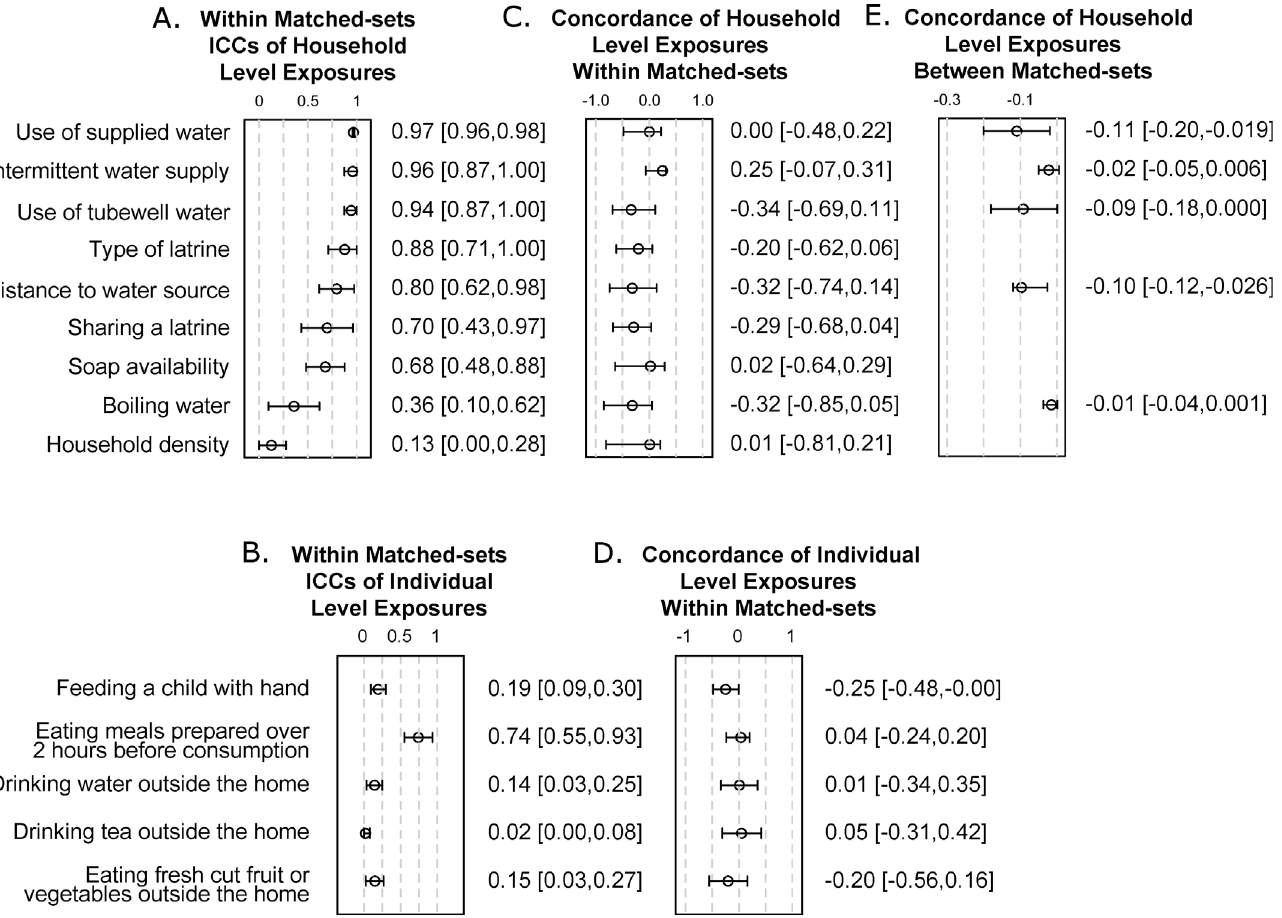
Fig 2. Clustering of individual exposures. A,B) Intraclass correlation coefficients (ICCs) and 95% confidence intervals of A) household level exposures and B) individual level exposures. All household level exposures except household density and boiling water showed clustering within matched-sets. For individual level exposures, only eating a meal prepared over 2 hours before consumption showed strong clustering. C,D) Linear association between the concordance of C) household level and D) individual level exposures within matched-sets and the spatial extent of matched-sets. Clustering within each matched-set (within matched-set concordance) was the proportion of pairs of households (or individuals) within the matched-set that had the same exposure. The spatial extent of matched-sets was the median distance between any two households within the matched-set. The coefficients and 95% confidence intervals specified the change in concordance per 100 meters increase in the spatial extent of matched-sets. More spatially compact matched-sets tended to have higher concordance in exposures than the larger ones, though the trend was not statistically significant for any exposure. E) Five exposures appeared to show clustering beyond the extent of matched-sets based on visual inspection of LOESS plots in Fig 3. The coefficients and 95% confidence intervals specified the change in concordance per 100 meters increase in the distance between matched-sets up to the spatial extent of